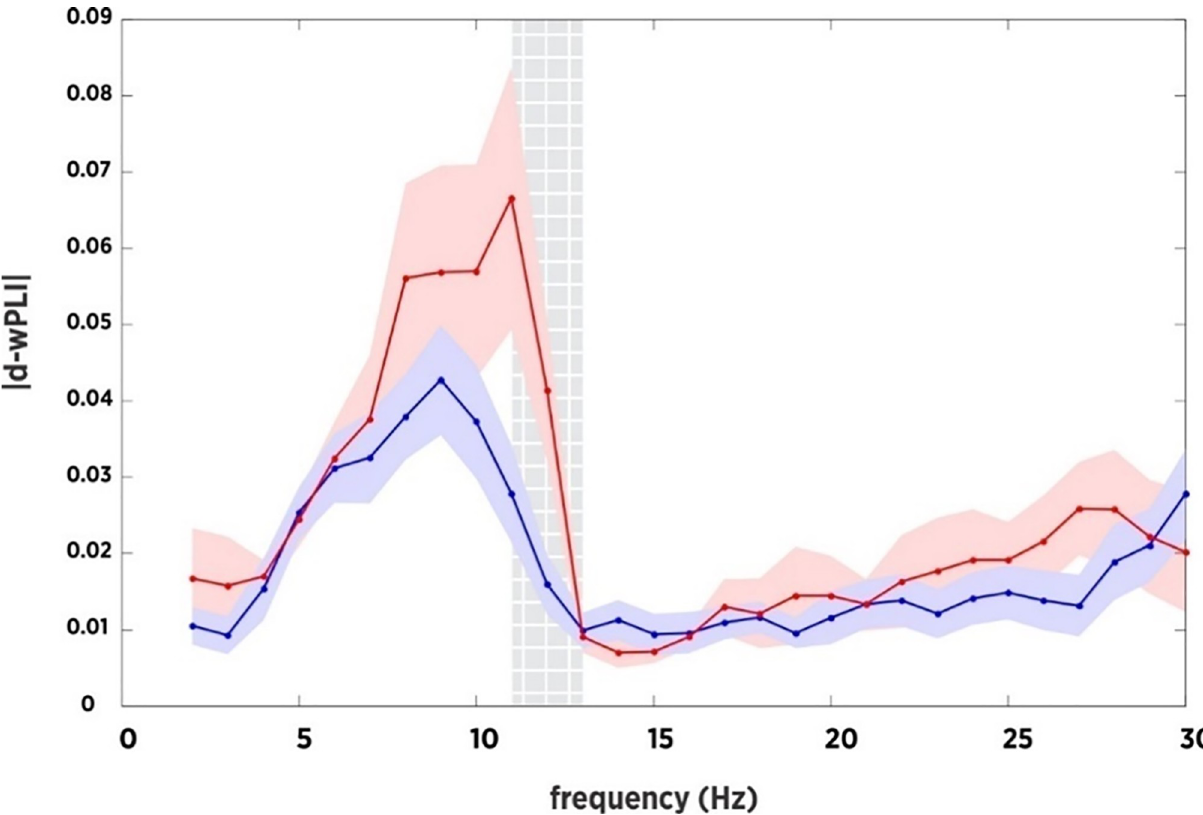
Fig 1. Differences in alpha functional connectivity between the dialogic reading and screen stories intervention groups. The screen stories group (red) showed significantly increased alpha functional connectivity (debiased wPLI) compared to the dialogic reading group (blue). A contiguous band of increased connectivity was observed between 10 and 13 Hz, in 0.5 Hz